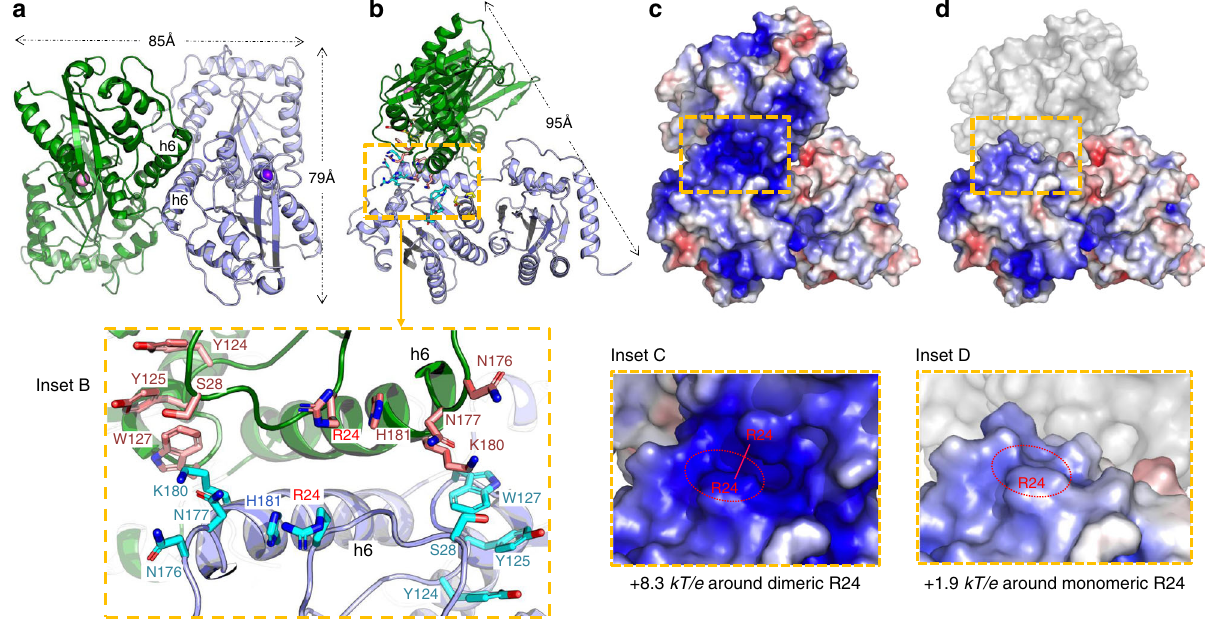
Fig. 2 The overall features of a full-length rA3G dimer and the enhanced electrostatic potential at the dimer junction. a , b Two views of the dimeric rA3G of the E/Q structure, with the two subunits colored in green and light-blue. The dimensions of the dimer are indicated. Inset B a close-up view around the box area in yellow dashed line in b , showing 18 charged/polar and hydrophobic residues from two subunits circling the dimeric junction. Centered around the two R24, the location of these residues is suitable for binding single-stranded nucleic acids through charge interactions with phosphate backbone and hydrophobic stacking with the bases. c , d The surface charge calculated from rA3G dimer as viewed in b ( c ) or from the light-blue rA3G monomer in b ( d ). The averaged electrostatic potentials (EP) calculated for the rA3G dimer is + 8.3 kT/e for area centered around the R24 across the dimer junction (in dashed box in c , and Inset c in close-up), whereas the averaged EP for an rA3G monomer is 1.9 kT/e around the same R24 area (in dashed box in d , and Inset d in close-up) (see Methods on electrostatic potentials calculation, and calculated EP values are provided as a Source Data fi le), which indicates a signi fi cant enhancement of the positive EP around R24 area due to